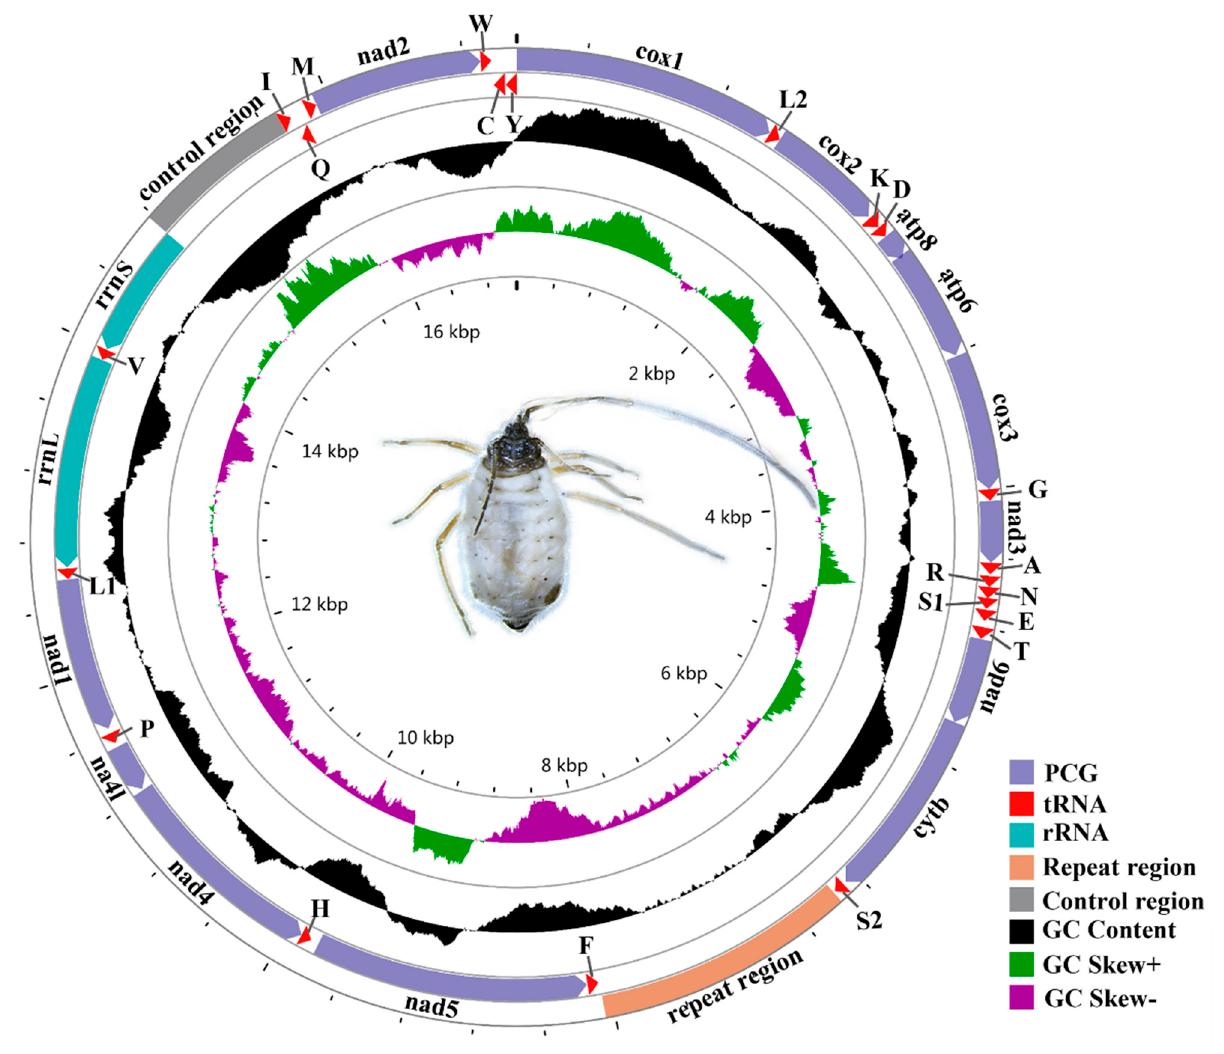
Figure 1. Circular map of the complete mitogenome of Stomaphis sinisalicis . Different colors indicate different types of genes and regions. Genes shown at the outer circle are located on the J strand, and those at the inner circle are located at the N-strand.